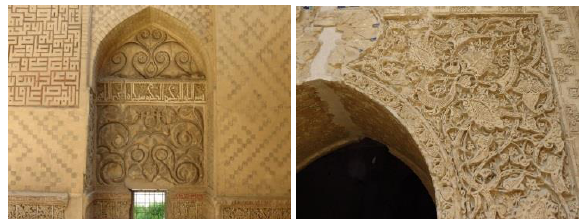
Figure 10. Pir Bakran Mausoleum, Imna, 2013